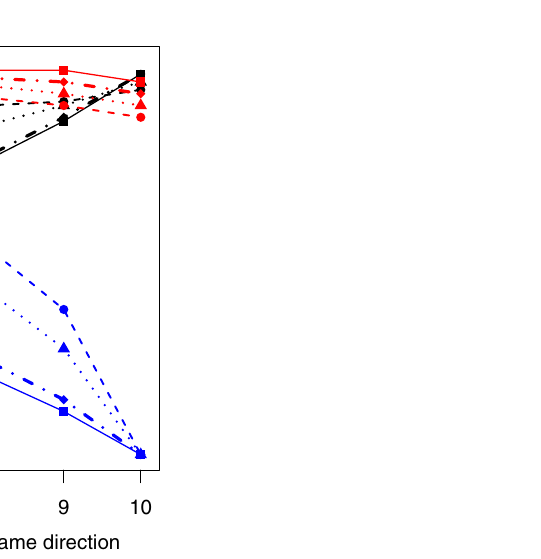
Figure 1. Empirical power when there are 10 out of 20 p -values are significant with model = “Expo”, ρ = 0.5 , and µ = 2 .